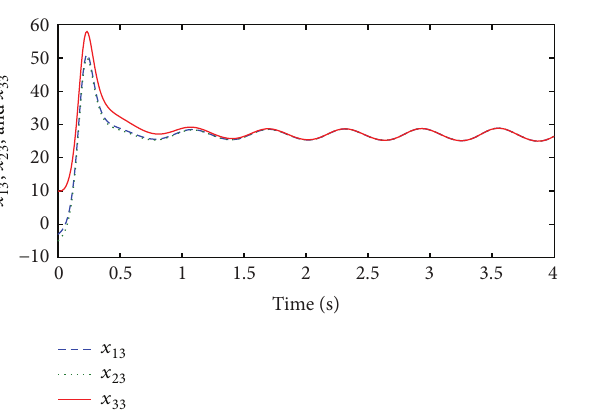
Figure 4: The state trajectories 𝑥 13 , 𝑥 23 , and 𝑥 33 of the Lorenz sys- tems with time 𝑡